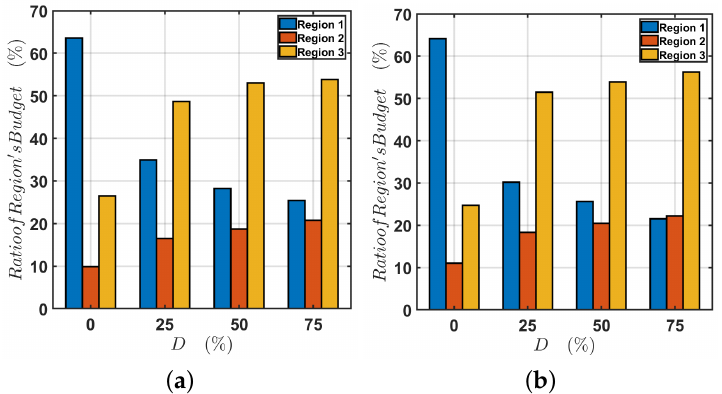
Figure 4. Under FBCRPA scheme, the budget proportion of regions under different M . ( a ) M = 0.5. ( b ) M = 1.